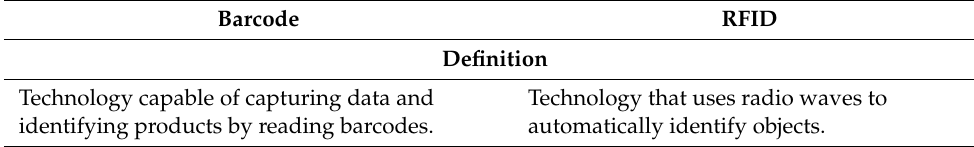
Table 3. Comparison between barcode and RFID (adapted from